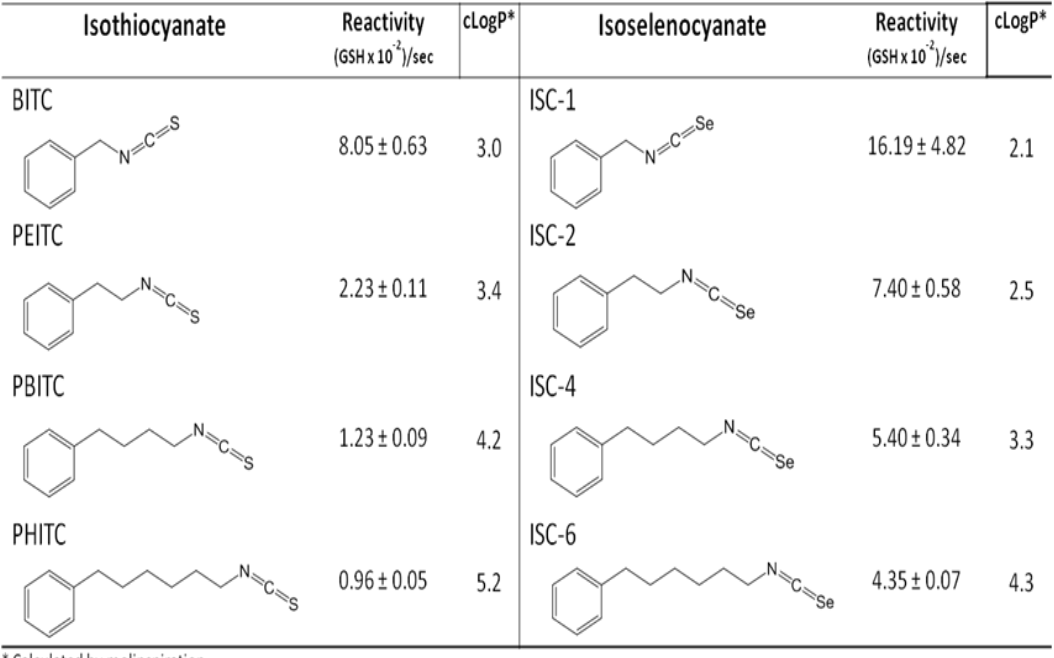
Figure 5. Comparative catalytic oxidation of GSH by isothiocyanates and isoselenocyanates, adapted from